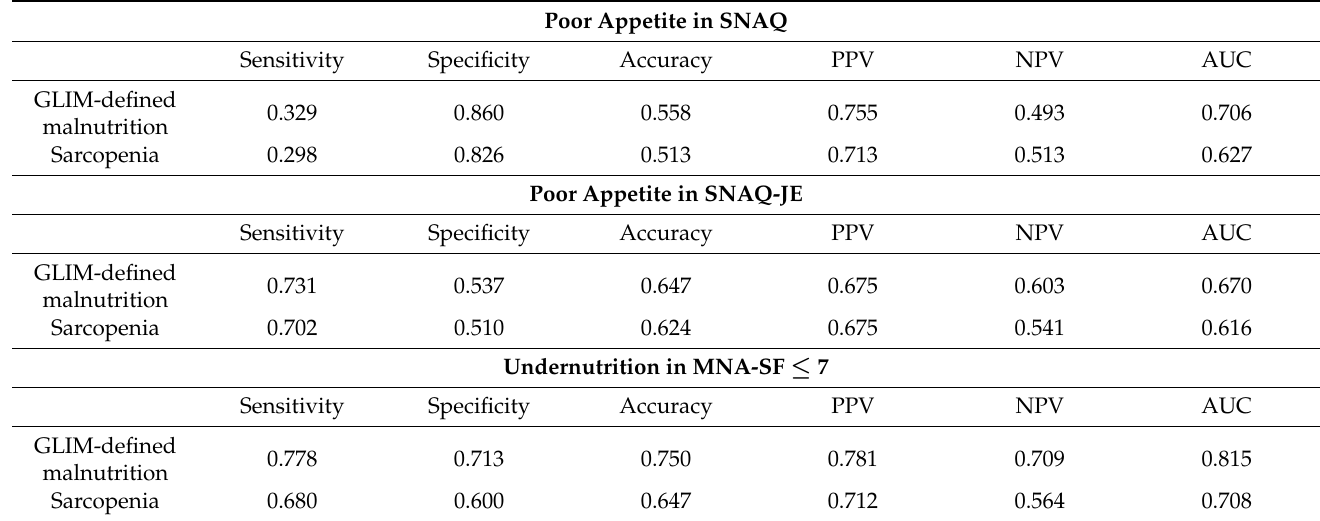
Table 4. Accuracy of poor appetite and reference tools as predictors of current GLIM-defined malnutrition and